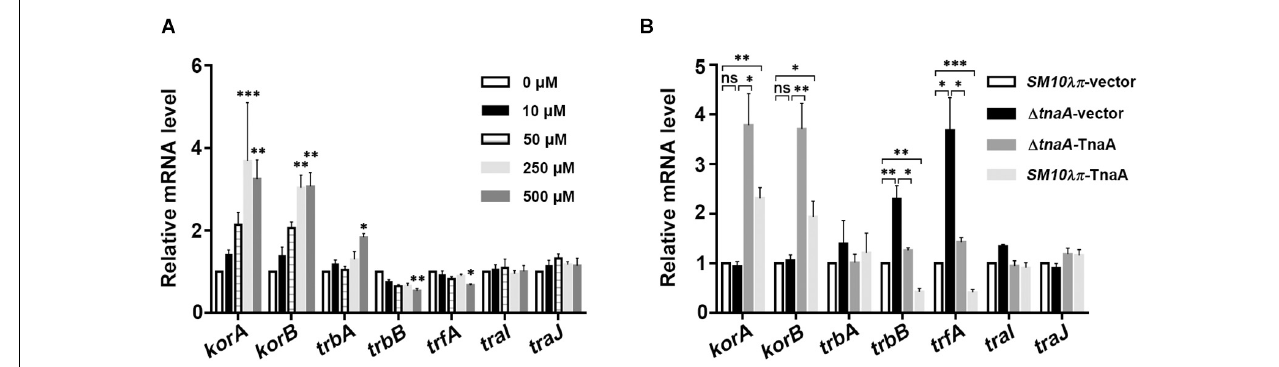
FIGURE 2 | The mRNA expression level of conjugation-associated genes. (A) Effect of exogenous indole on the expression levels of conjugation genes ( trbB , trfA , traI , and traJ ) and global regulatory genes ( korA , korB , and trbA ). SM10 λπ (1 × 10 7 CFU/ml) was treated with different concentrations of indole at 37 ◦ C for 3 h, followed by real-time PCR analysis. (B) Effect of endogenous indole on the expression of the aforementioned conjugation-associated genes. The indicated SM10 λπ strains were mated (1 × 10 7 CFU/ml) at 37 ◦ C for 3 h, followed by real-time PCR analysis. The rpoD gene of SM10 λπ was used as an internal control. Values are means ± SEMs from at least three independent experiments; ∗ P < 0.05; ∗∗ P < 0.01; ∗∗∗ P < 0.001; ns, not